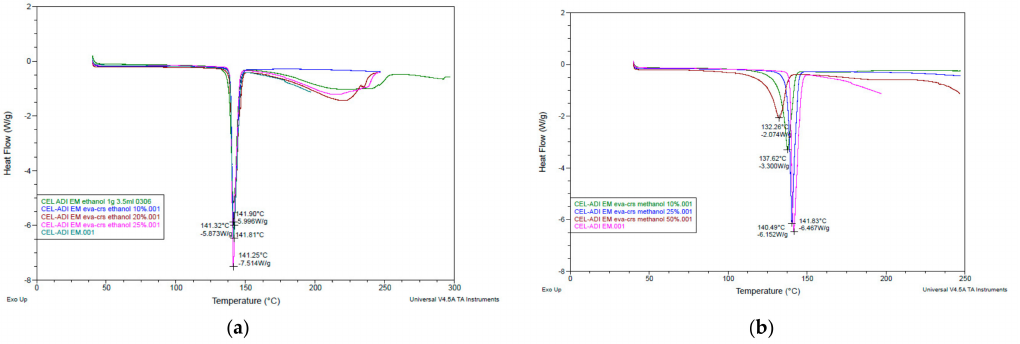
Figure 3. DSC results of CEL-ADI EM: ( a ) ethanol-assisted EM; ( b ) methanol-assisted EM.